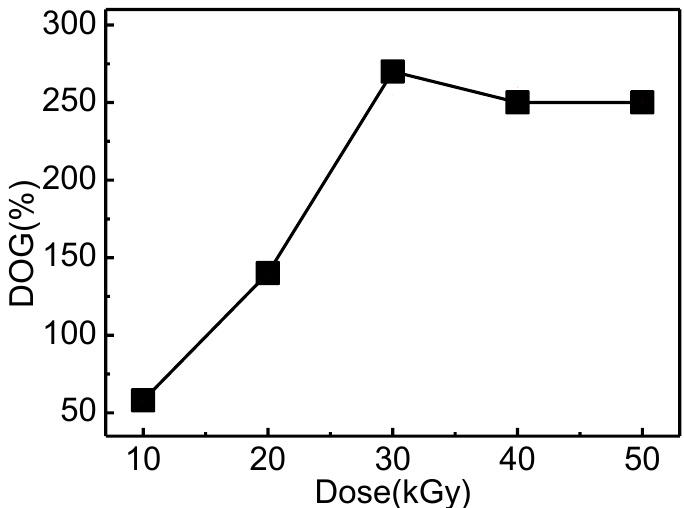
ff ect of radiation dose on the degree of grafting Figure 2. Effect of radiation dose on the degree of grafting (DOG). Figure 2. E